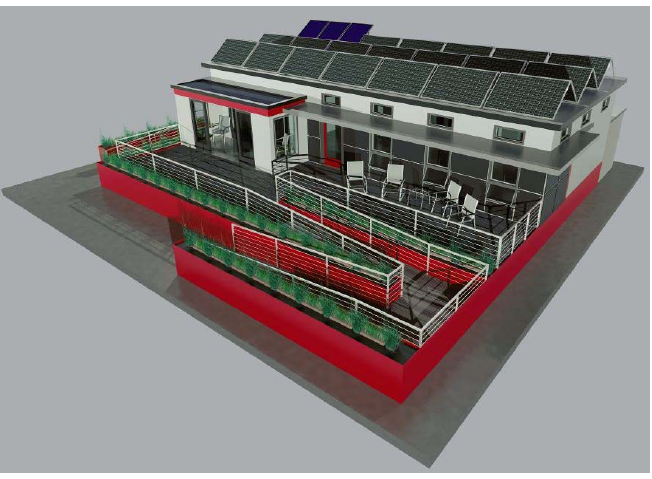
Figure 2. Exterior rendering of the Chameleon